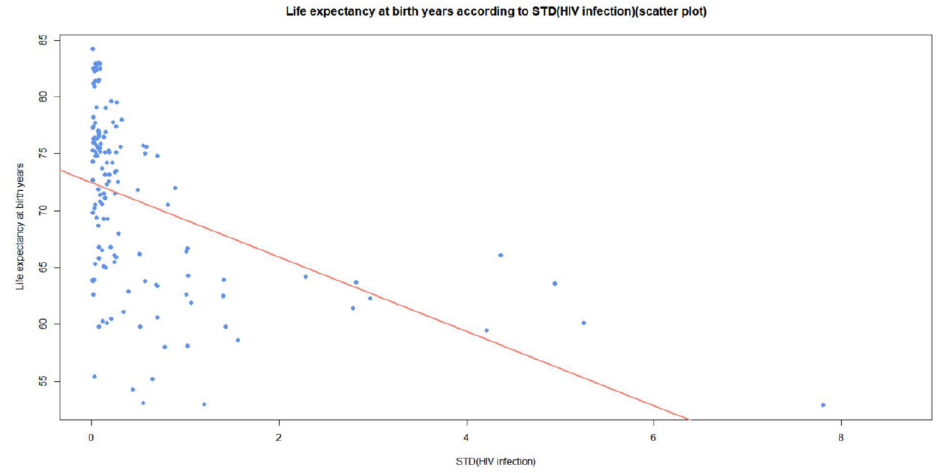
Figure 16. Scatterplot for STDs (HIV infection) and life expectancy at birth years.